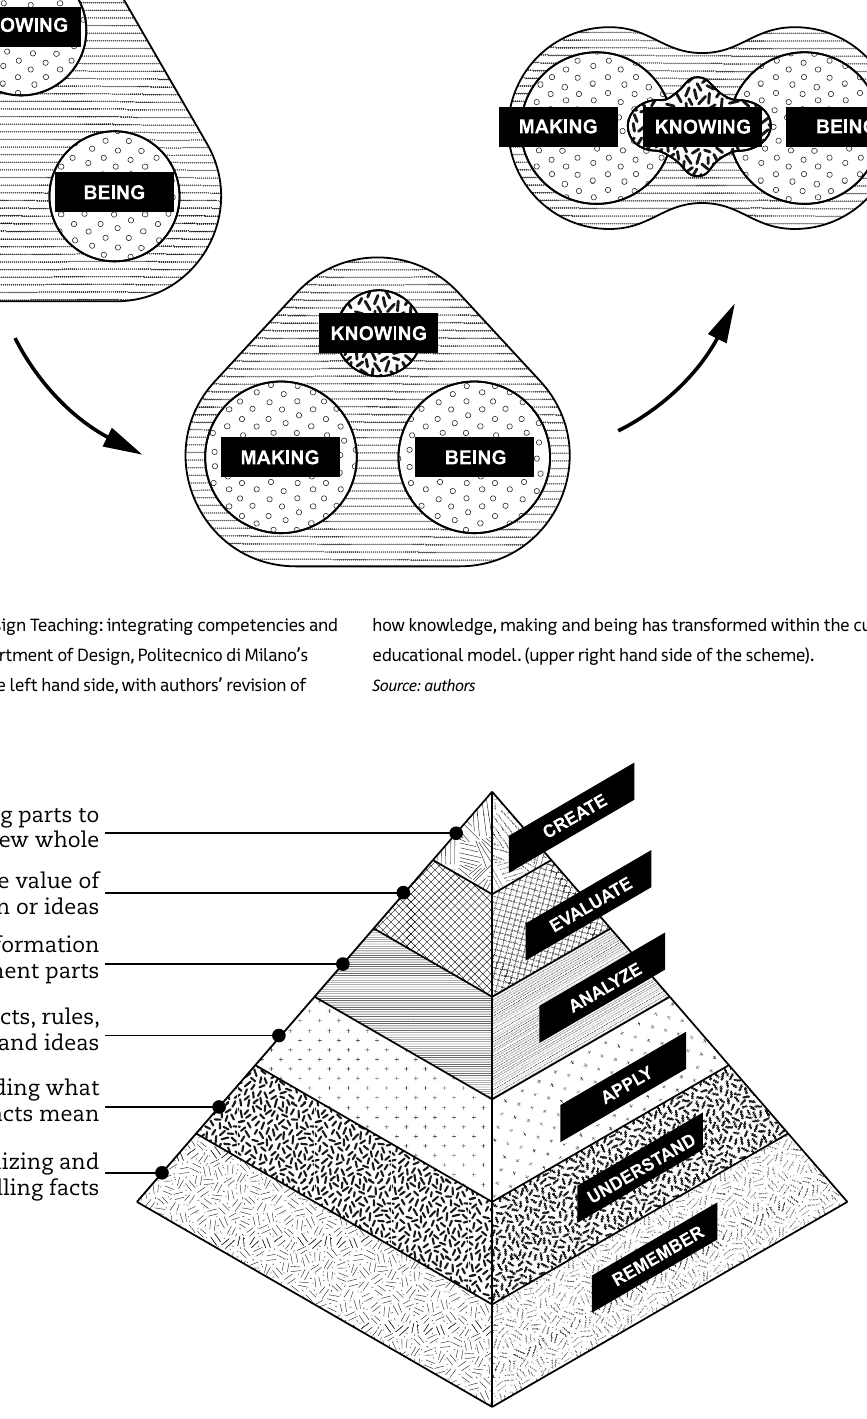
Figure 2: Bloom's taxonomy. Adaptation from Bloom (1956)